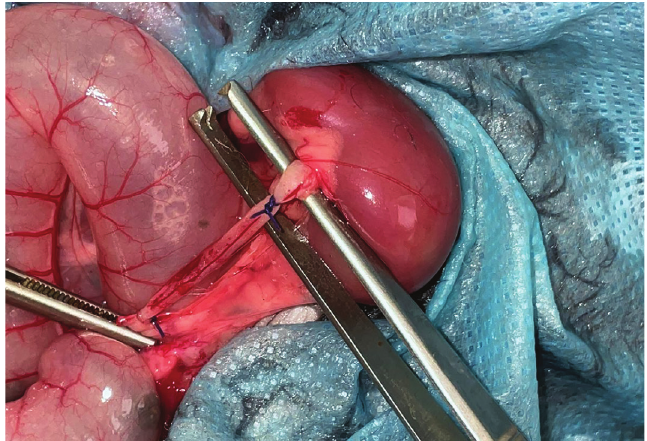
Figure 1 - Blocking of the upper third of the left ureter.